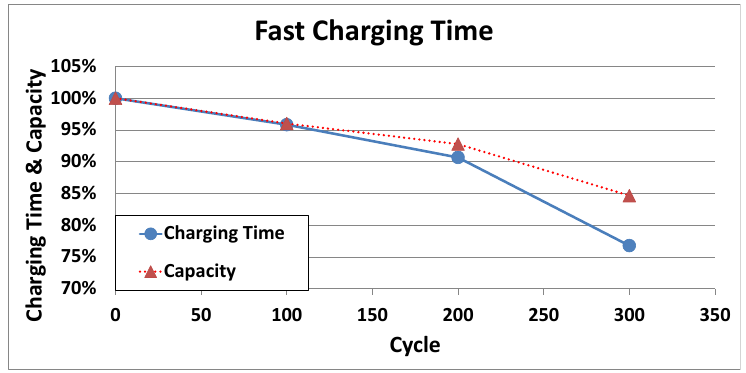
Figure 5. Variation in the battery charging time and capacity with increasing cycle numbers.